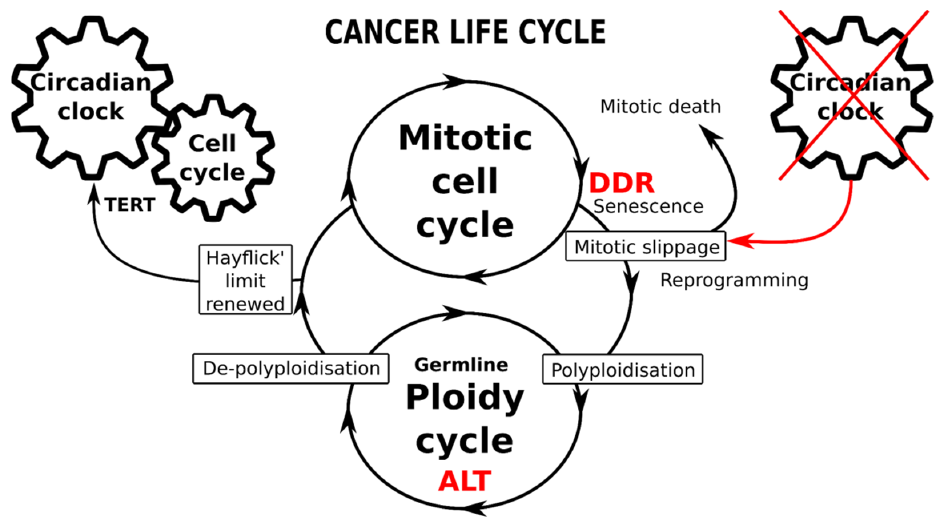
Figure 5. Schematic of the immortal cancer life-cycle composed of two reciprocally joined mitotic and ploidy cycles. The mitotic cell cycle is driven by the circadian clock (CC), particularly operating the telomerase-dependent telomere maintenance pathway (TERT). The transition from mitotic to ploidy cycle occurs after DNA checkpoints are adapted during the DNA damage response (DDR), through mitotic slippage coupling accelerated cellular senescence (with compromised telomeres) and reprogramming to whole-genome duplications. Transition into the ploidy cycle, concurrent with a germline expression signature, is associated with interruption of the circadian clock and restoration of eroded telomeres by alternative telomere lengthening (ALT). Return of depolyploidised offspring to the mitotic cycle restores the TERT-pathway and the CC-driven count of the Hayflick limit. The adaptive response to genotoxic, oncogenic or oxidative stress induces ACS